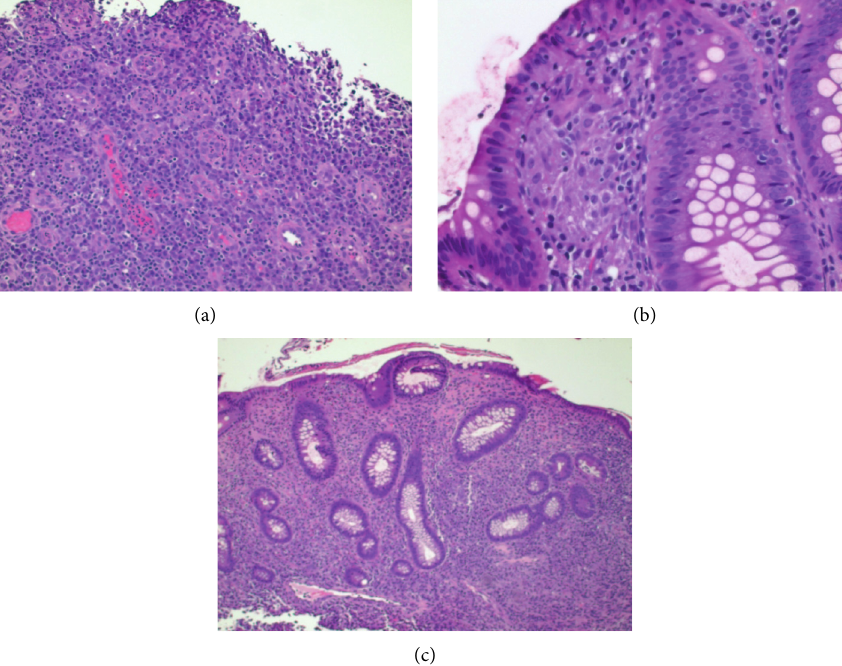
Figure 2: Hematoxylin and eosin (H&E) staining of the hepatic flexure mass, revealing focal active chronic colitis with ulceration, polypoid granulation tissue formation, reactive epithelial, and noncaseation granulomatous changes. Basal cell plasmacytosis could not be demonstrated. Hematoxylin and eosin (H&E) staining of the normal-appearing colon revealing the chronic colitis and preserved crypt